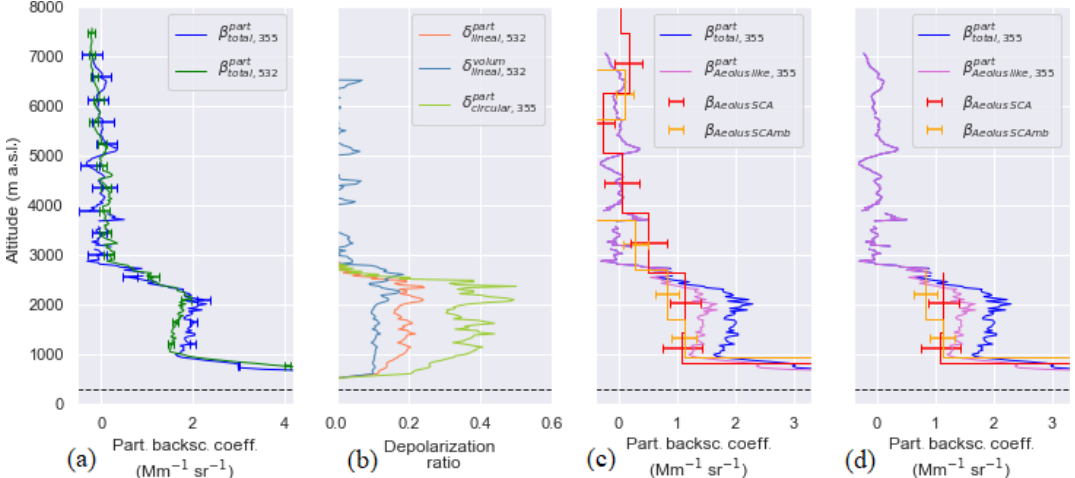
Figure 9. Vertical profiles for the case study in Évora on 28 June 2019: (a) ground-based particle backscatter coefficient profiles at 355 and 532nm with their uncertainties; (b) ground-based volume and linear particle depolarization ratios at 532nm and the derived circular particle depolarization ratio at 355nm; (c) Aeolus SCA and SCAmb co-polar particle backscatter coefficients (without quality flags) and the corresponding Aeolus-like ground-based backscatter coefficient. Panel (d) is the same as panel (c) but considering preliminary quality flags. Ground-based lidar profiles were obtained from the continuous measurement of the system from 17:30 to 19:00UTC. Satellite-based profiles correspond to the Aeolus overpass at 18:17UTC.